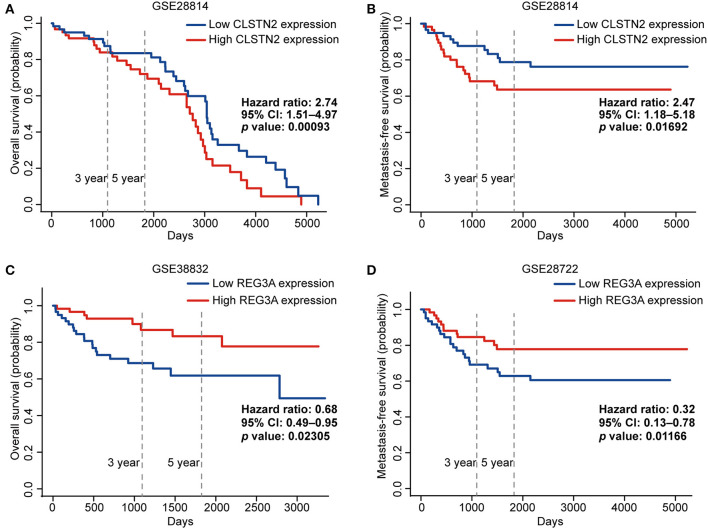
The prognostic values of CLSTN2 and REG3A in colorectal cancer patients (PROGgeneV2).The overall survival curve (A) and metastasis-free survival curve (B) of CLSTN2. The overall survival curve (C) and metastasis-free survival curve (D) of REG3A.